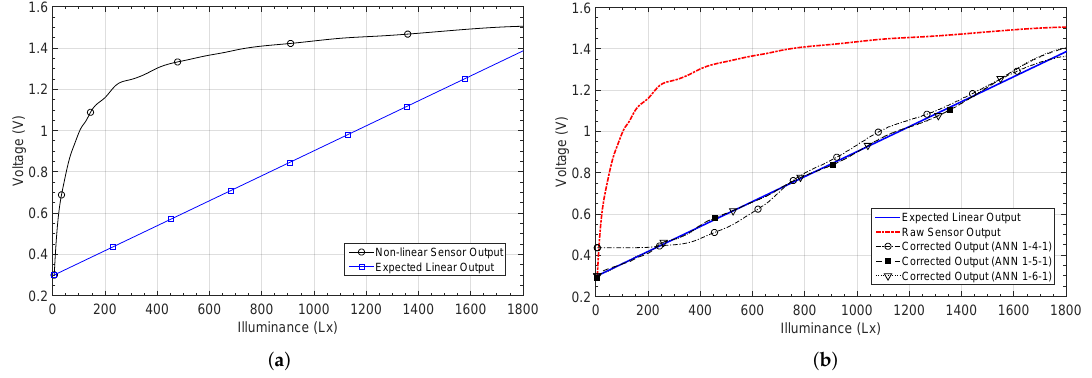
Figure 14. LDR sensor output response NL3 ( a ) before and ( b ) after correction.